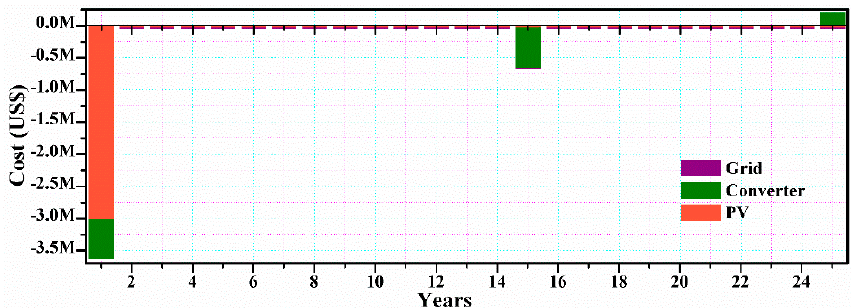
Figure 16. Yearly cash flow diagram of scenario 5 by components.